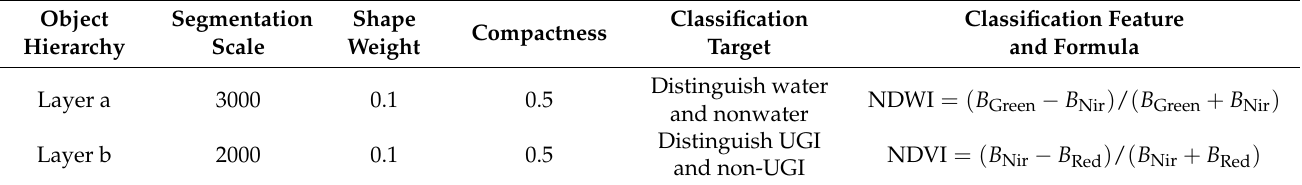
Table 2. Multiscale segmentation parameters and classification features.